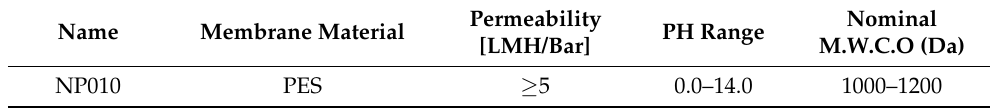
Table 1. Membrane information in the experiment.